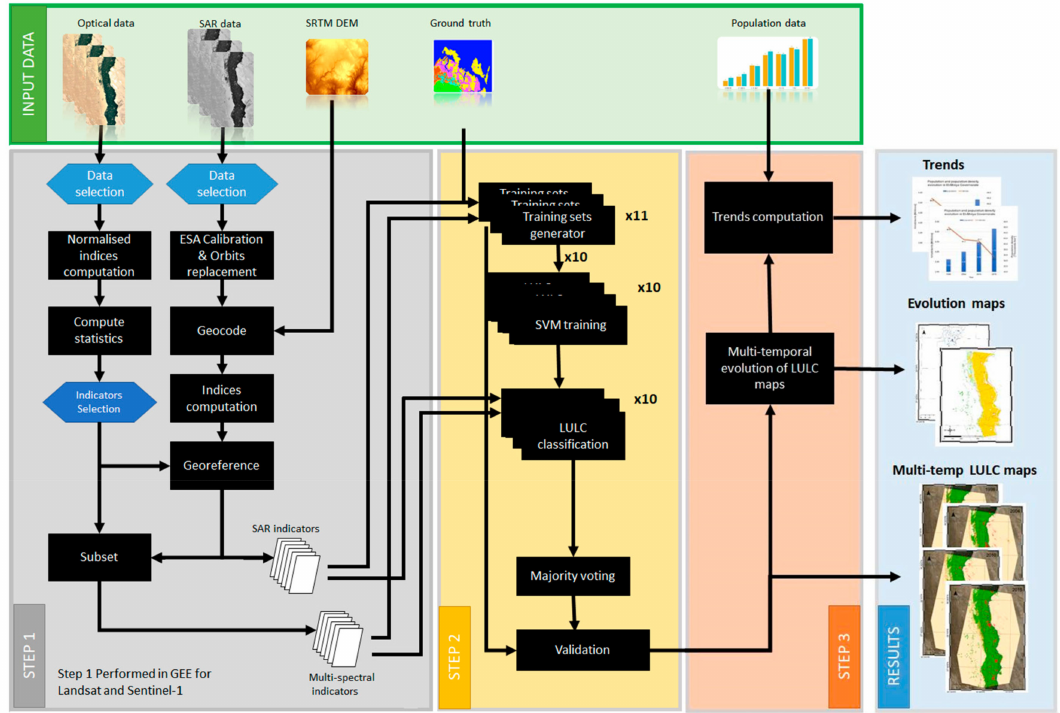
Figure 3. Overview of the methodological approach with the three steps discussed in the